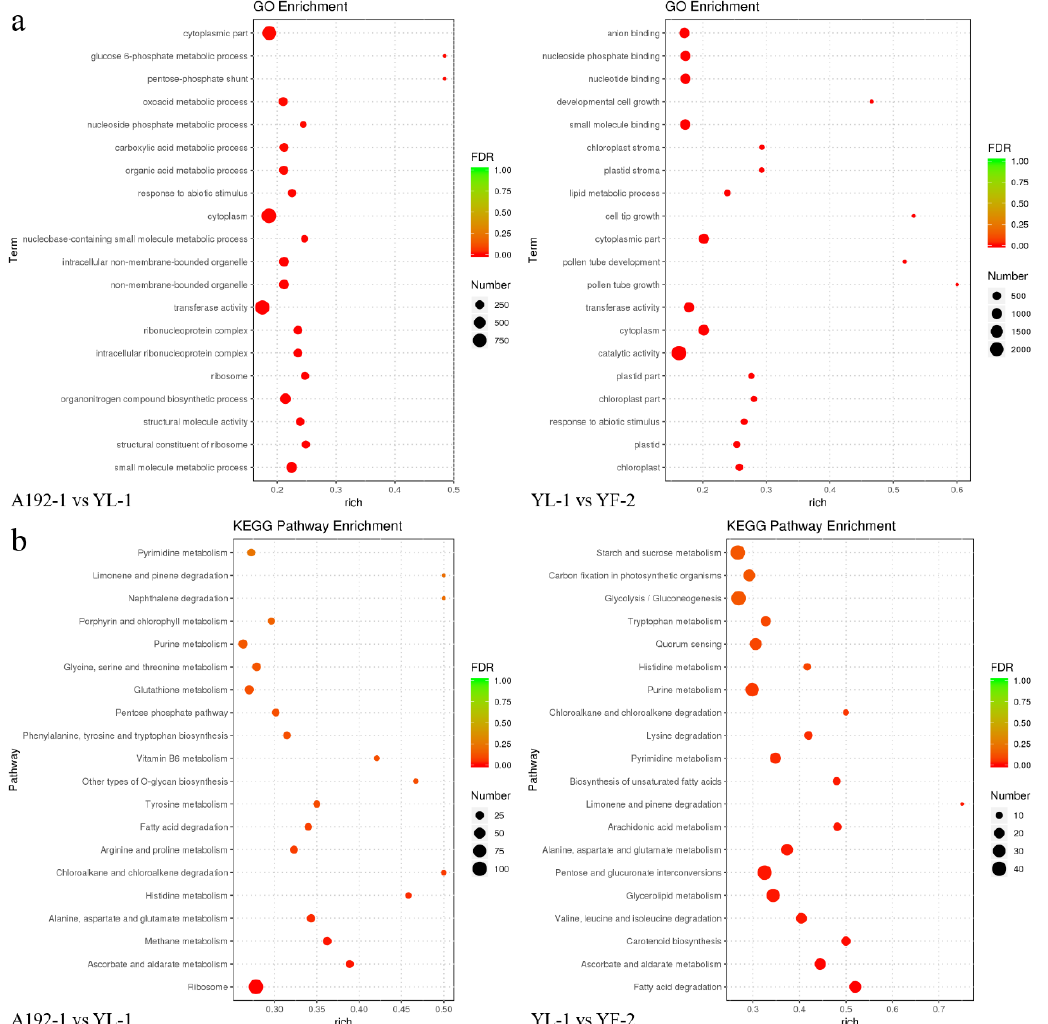
Figure 3. Top 20 enriched GO terms and KEGG pathways in the A192-1 vs. YL-1 and YL-1 vs. YF-2 comparison groups. ( a ) GO terms for the three comparison groups. The X-axis represents the rich factor, and the Y-axis represents the GO terms. ( b ) KEGG pathways for the three comparison groups. The X-axis represents the rich factor, and the Y-axis represents the pathway terms.